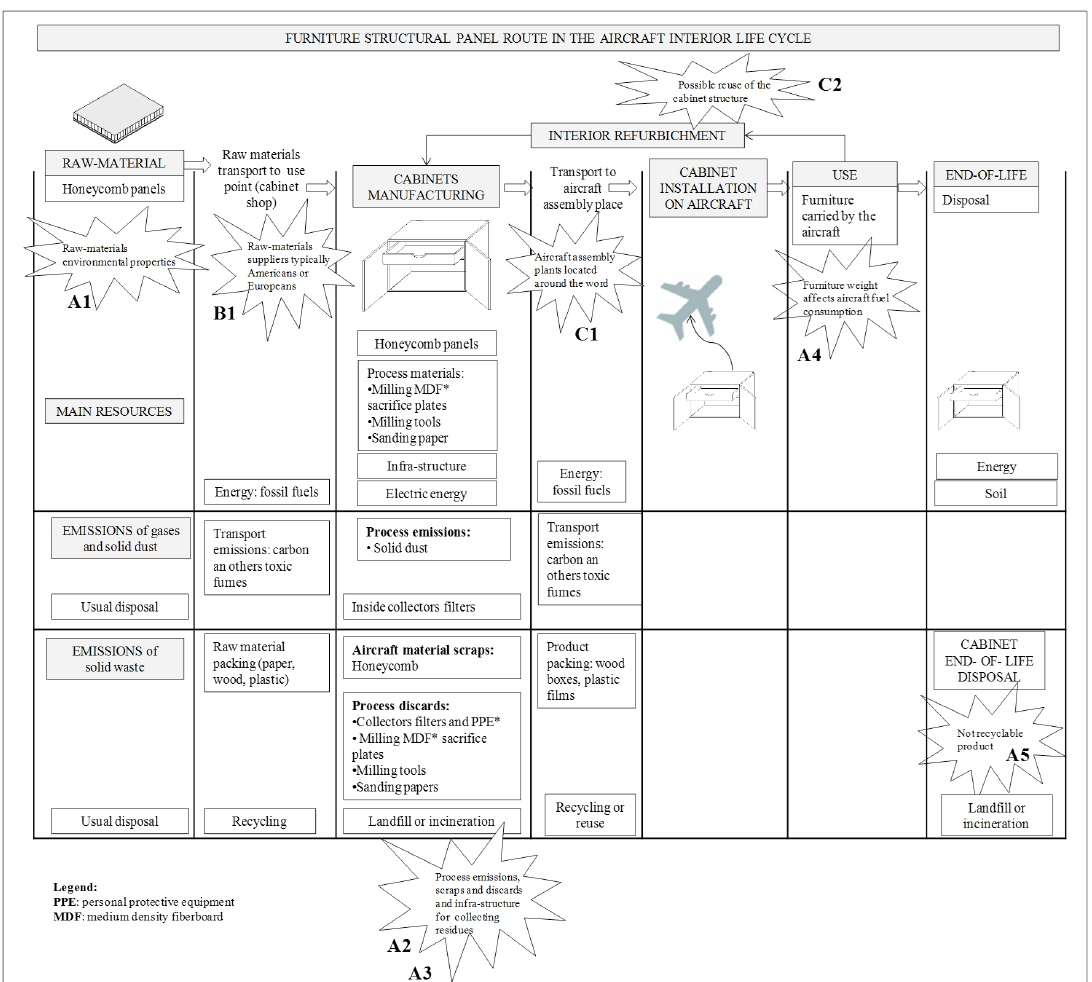
Figure 4: Honeycomb sandwich panel route analysis in the aircraft interior life cycle to produce environmentally friendly